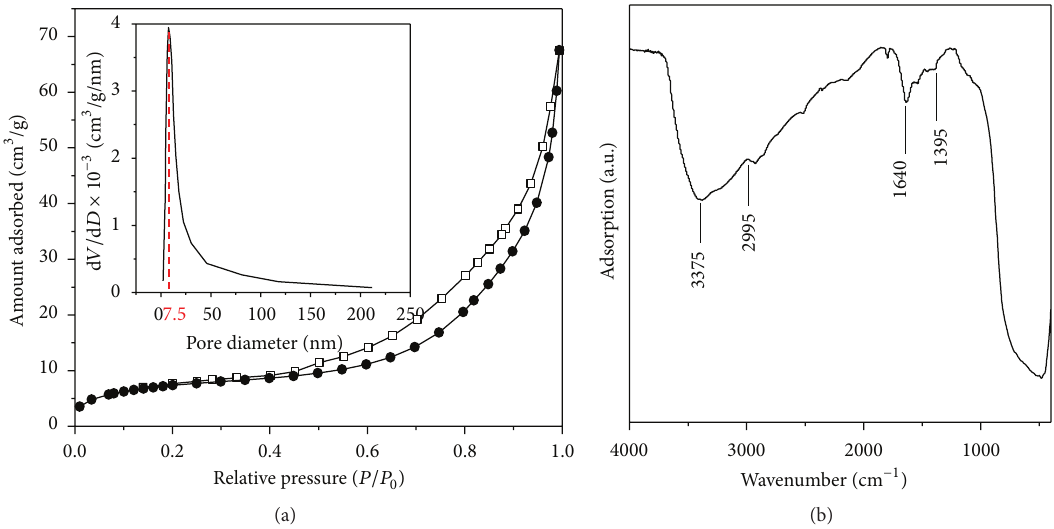
Figure 3: (a) N 2 adsorption/desorption isotherms of the prepared TiO 2 nanotubes and BJH pore-size distribution plot (insert). (b) FT-IR spectrum of the obtained porous TiO 2